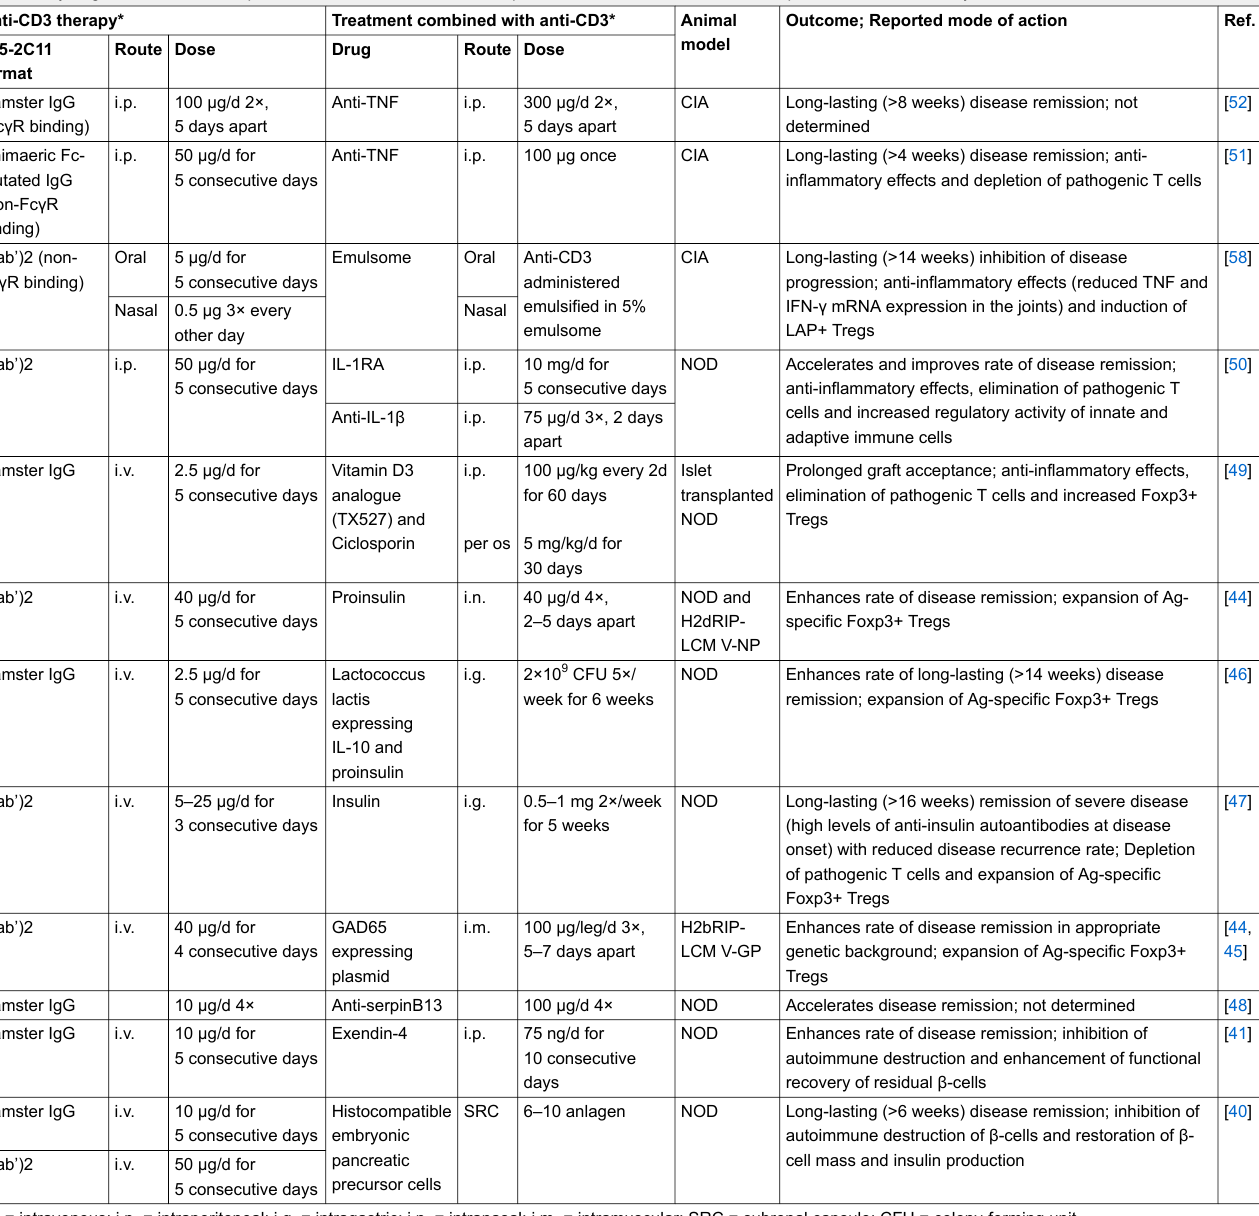
Table 2: Synergism between CD3-specific antibodies and various therapeutic interventions in established experimental autoimmunity. Anti-CD3 therapy* Treatment combined with